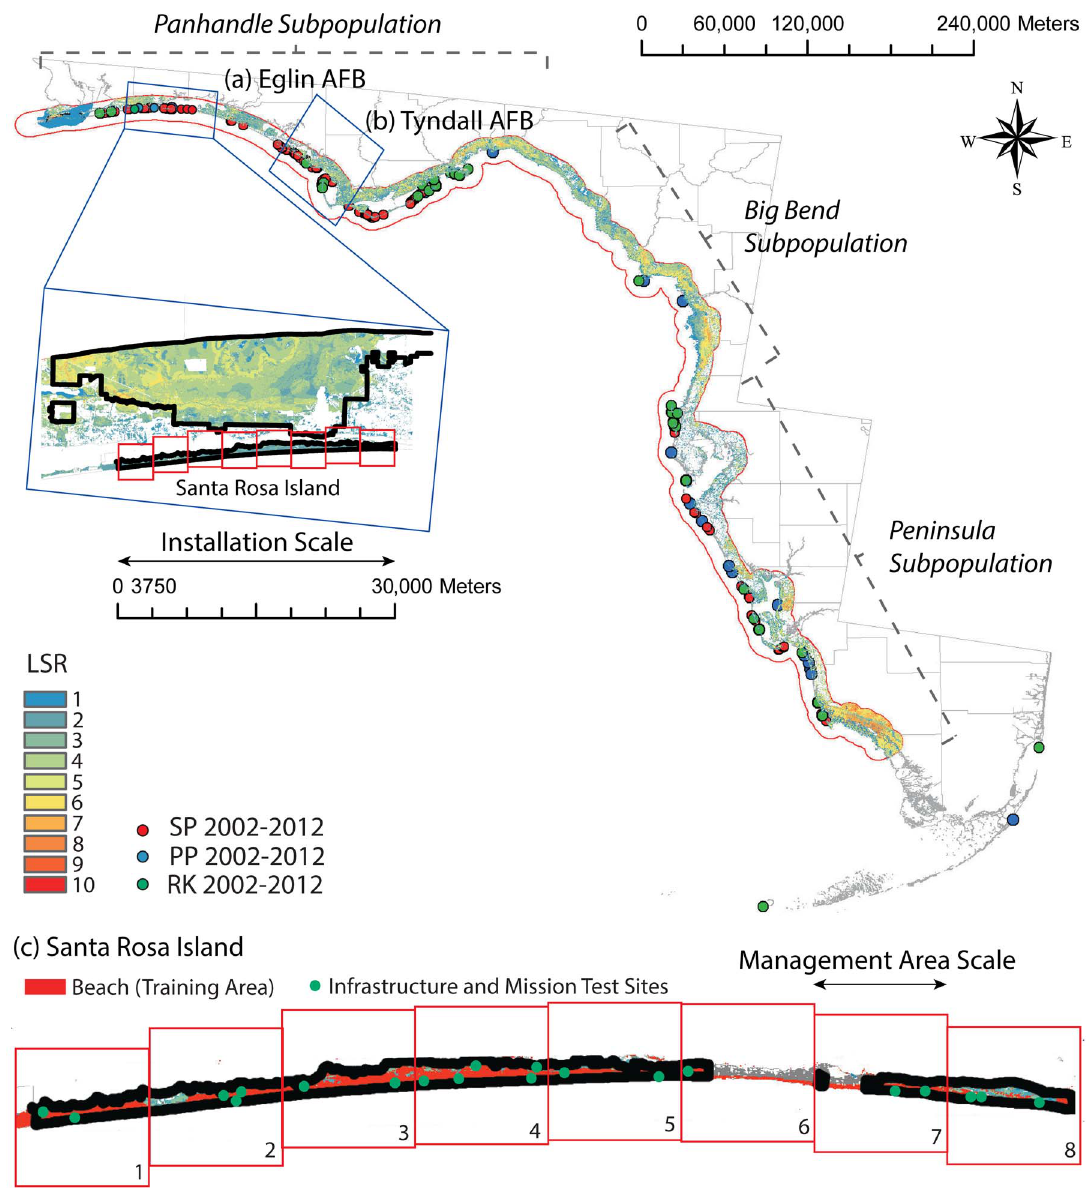
Figure 1. Region of the case study. The local species richness (LSR) and the occurrence of Snowy Plover (SP), Piping Plover (PP), and Red Knot (RK) are reported in the map. The Panhandle – Big Bend – Peninsula within the black line is the region considered in our biophysical modeling effort (land cover, habitat suitability, and metapopulation model). Considering the extent of each management area (3750 m 2 ), 192 management areas in the whole Gulf of Mexico coastal ecosystem of Florida were considered. Eight management areas cover the portion of Santa Rosa Island managed by Eglin Air Force Base (EAFB) (a). (b) Tyndall Air Force Base that is the hotspot of SP, hosting about 60% of the whole SP population in Florida.